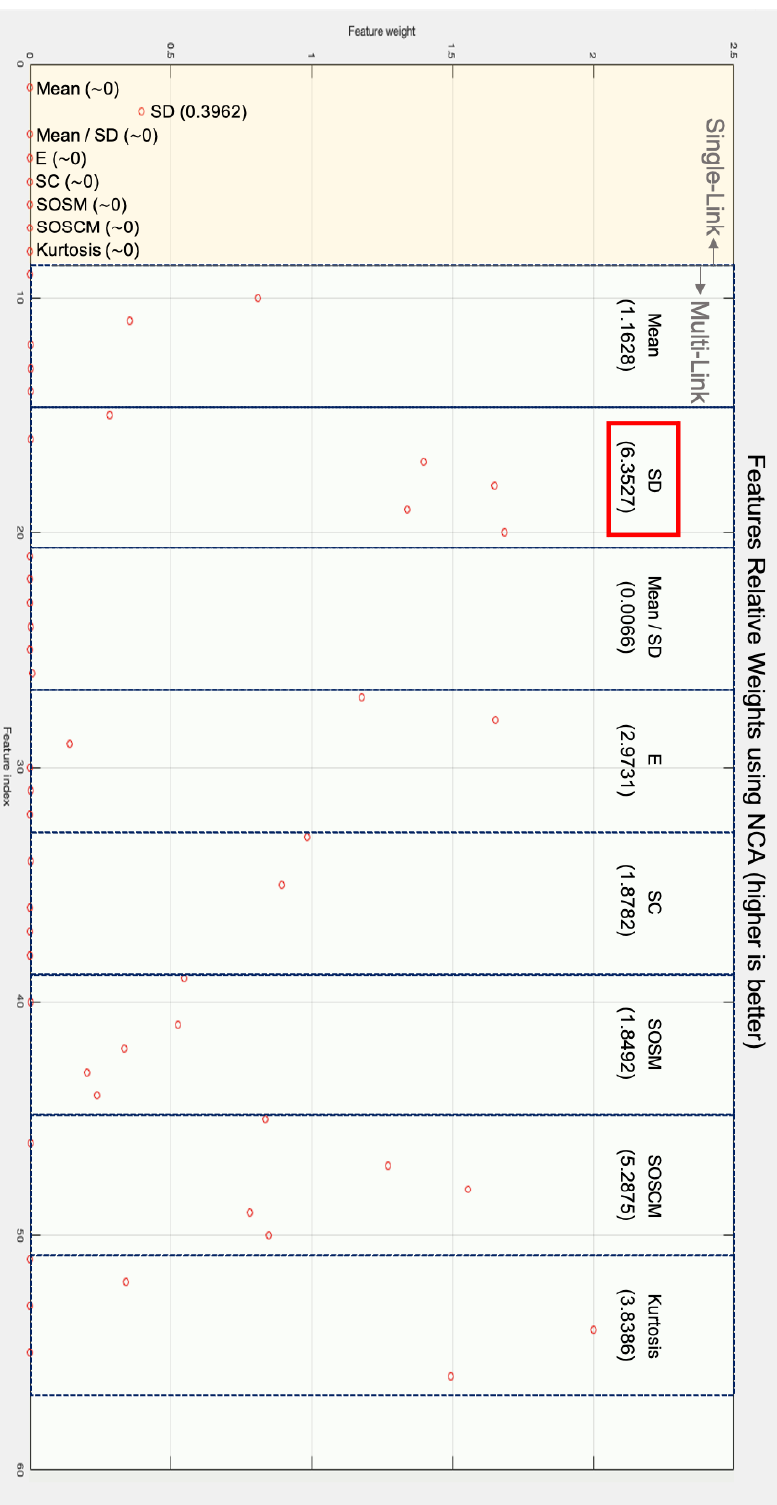
Figure 4. Relative Weights of Features using Neighborhood Component Analysis (NCA) (higher is